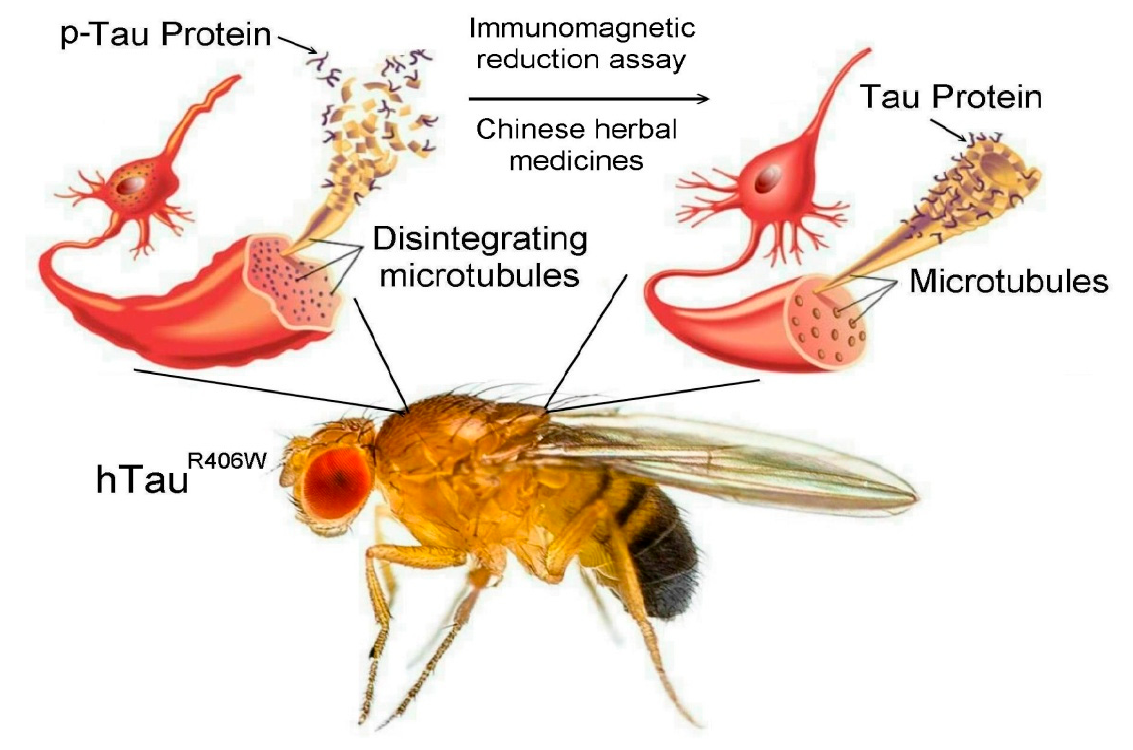
Figure 1. Schematic illustrating the more favorable therapeutic effects of Chinese herbal medicine treatment, which alleviates Tau-induced toxicity in hTau R406W Drosophila flies.